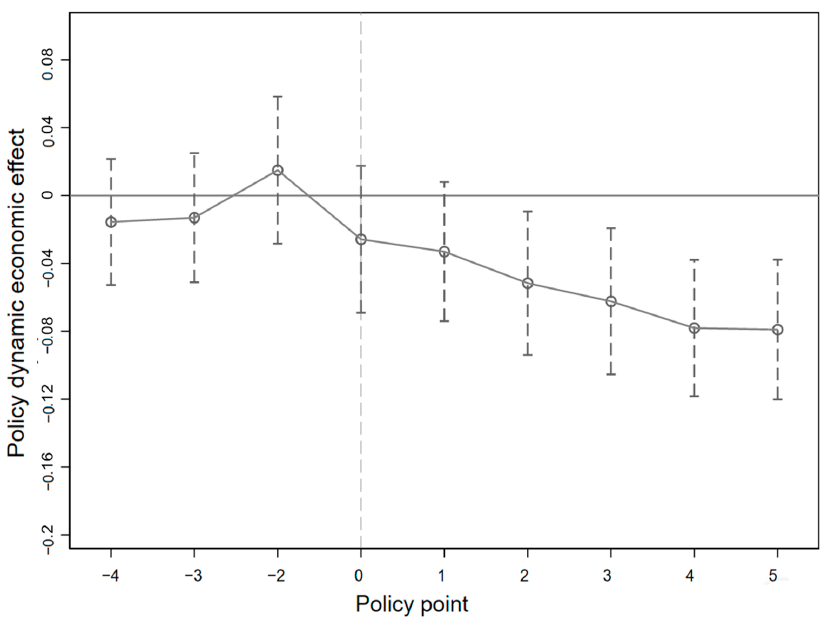
Figure 6. Parallel trend test and dynamic policy effect analysis of OLS.